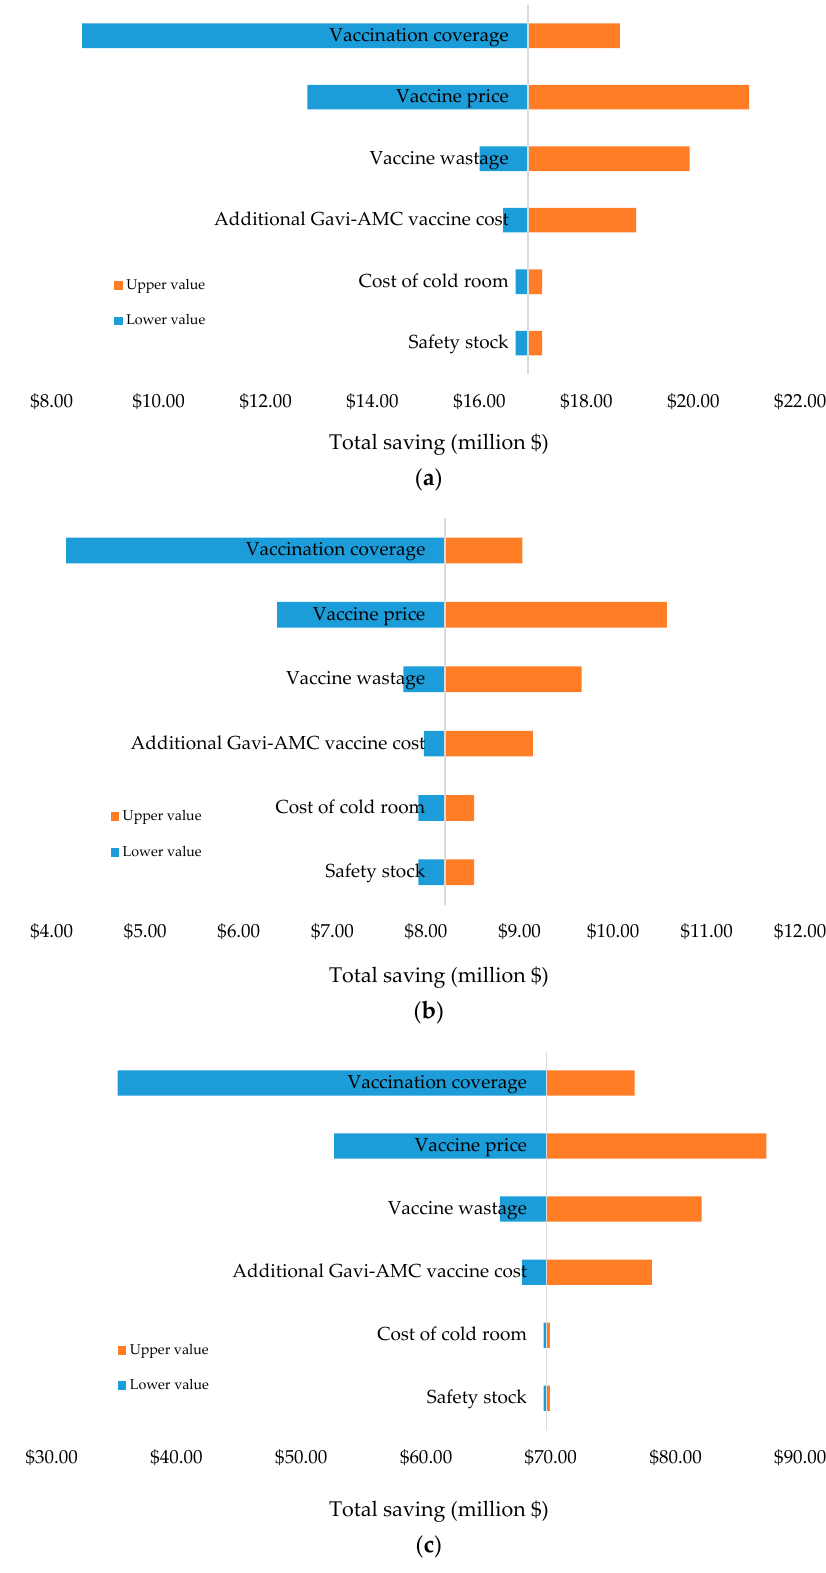
Figure 1. ( a ) Effect of different input parameters on total saving in the multi-dose PCV13 scenario. ( b ) Effect of different input parameters on total saving in the multi-dose PCV10 A scenario. ( c ) Effect of different input parameters on total saving in the multi-dose PCV10 B scenario.